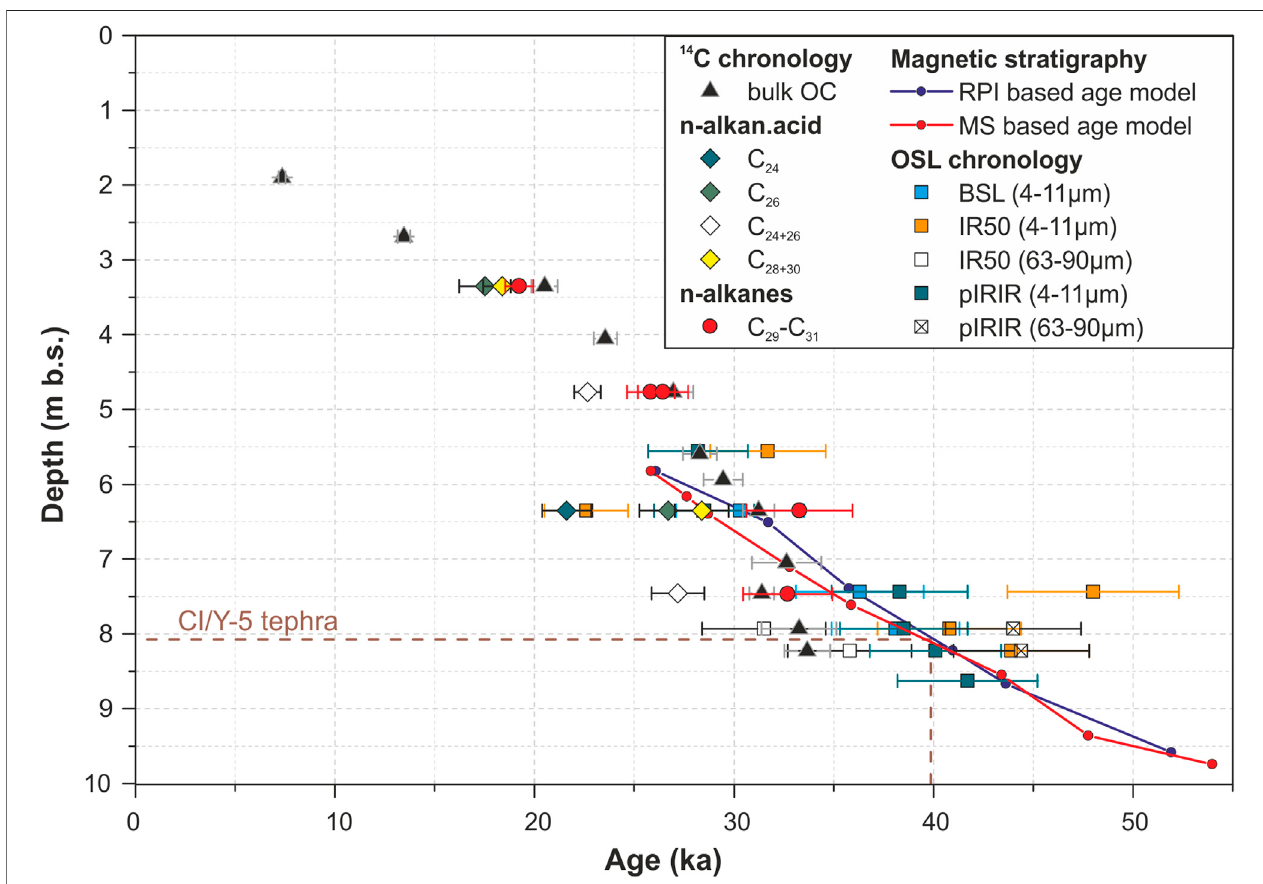
FIGURE 9 | Ages determined for BAK using the different methods. Outliers are not shown. For better visibility, n -alkane 14 C ages are not distinguished based on chainlength and onlythe meanage ofthetie points ofthemagnetic stratigraphy-basedage model areshown. OSL dataerrorbars re fl ect1 σ uncertainty.Calibrated 14 C ages are presented with 95% (2 σ ) con fi dence intervals. The age-depth relationship of the tephra layer is depicted as a dashed line.